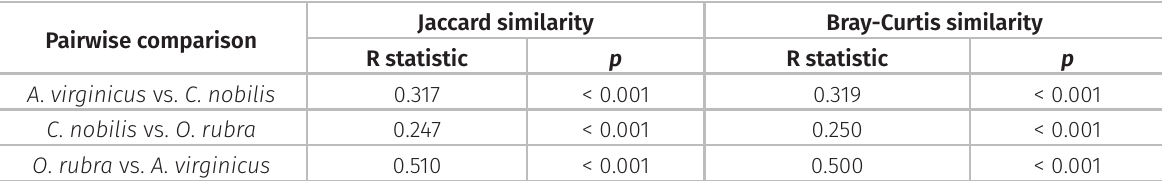
Table IV. Results of the Analysis of Similarities (ANOSIM) with 10,000 permutations, for qualitative (Jaccard) and quantitative (Bray-Curtis) similarities, estimated at infracommunity level and considering fish species as factor. Level of significance is p <